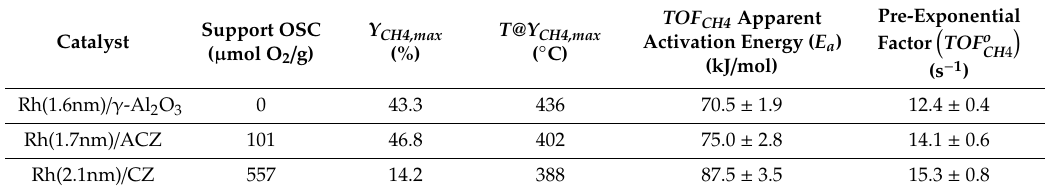
Table 2. Support-mediated promotion characteristics, apparent activation energies, and pre-exponential factors for CO 2 methanation reaction over Rh(1.6nm) / γ -Al 2 O 3 , Rh(1.7nm) / ACZ, and Rh(2.1nm) / CZ catalysts with di ff erent OSC of their